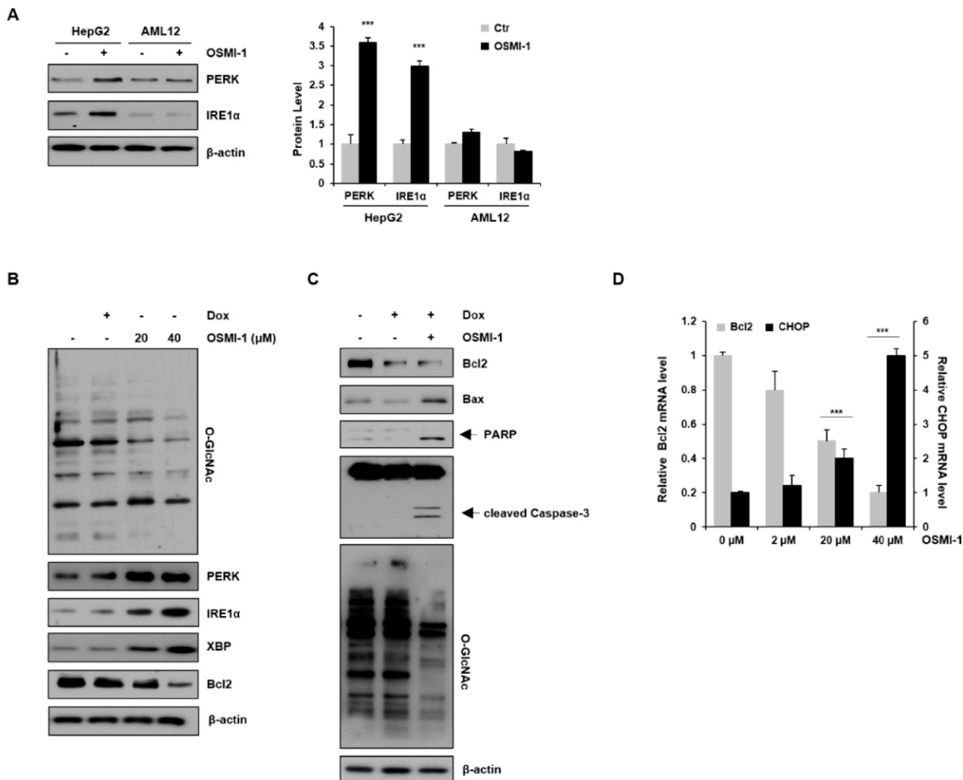
Figure 3. OSMI-1 stimulates the ER stress response. ( A ) HepG2 and AML12 cells were treated with or without 20 µ M of OSMI-1 for 15 h, and levels of protein-kinase-R-like endoplasmic reticulum kinase (PERK) and IRE1 α were detected via Western blotting. The graphs on the right show the relative amounts of protein as fold increase. *** p < 0.005 compared with the control group. ( B ) HepG2 cells were treated with DOX (0.4 µ M) or OSMI-1 (20 and 40 µ M) for 15 h. Western blot analysis was performed to detect levels of O-GlcNAcylated proteins, PERK, IRE1 α , XBP, and Bcl2. ( C ) HepG2 cells were treated with DOX (0.4 µ M) alone or in combination with OSMI-1 (20 µ M) for 15 h. Cell lysates were analyzed by Western blot using antibodies against Bcl2, Bax, cleaved PARP, caspase-3, and O-GlcNAcylated proteins. β -actin was used as an internal control. ( D ) HepG2 cells were treated with 0.4 µ M of DOX alone or in combination with various concentrations of OSMI-1 (2, 20, or 40 µ M). Levels of Bcl2 and CHOP mRNA were determined by qRT-PCR and normalized to the control sample. Values represent means ± SD ( n = 6). *** p < 0.005 compared with the control group, the uncropped western blot figures in Figure